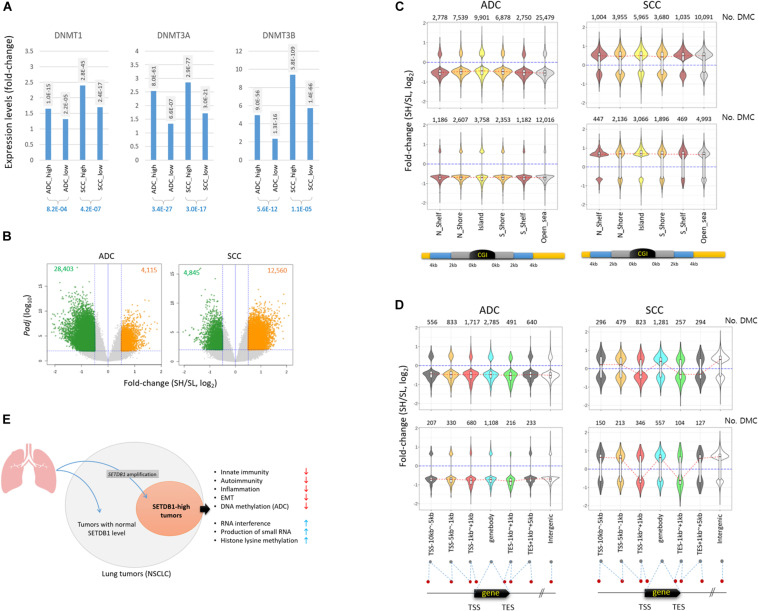
Different pattern of methylation change in ADC and SCC SETDB1-high samples. (A) The expression of DNA methyltransferase genes in lung cancer samples. The adjusted p-values (Padj) between each cancer group and normal group (shaded) and between the cancer groups (blue) are shown. (B) The volcano plots show the differentially methylated CpGs (DMCs) between SETDB1-high (SH) and SETDB1-low (SL) in TCGA LUAD/LUSC methylome data (Infinium HumanMethylation450 BeadChip). The methylome datasets were derived from the same patients’ tumors that we included in the transcriptome analysis in this study. The horizontal blue line indicates the threshold for significance (Padj = 0.01), whereas the two vertical blue lines represent the fold change cutoff (log2FC = 0.5). The number of hypermethylated CpGs in each group is denoted on the top of the plots. (C) The distribution of DMCs on CpG islands (CGIs) and surrounding regions in lung cancer samples. The violin plots show the fold change levels of significant DMCs in CGIs, shores, and shelves, as schematically depicted in the plots. (D) The distribution of DMCs in genic regions. The violin plots show the fold change levels of significant DMCs on genes and around the transcription start/end site (TSS/TES). The number of DMCs in each region is denoted in each plot. The red dotted lines connect the median fold change values of each region. The blue lines indicate the fold change = 0. (E) Illustration of the generation of SETDB1 level-based, different NSCLC molecular subtype and its singular features in biological processes.